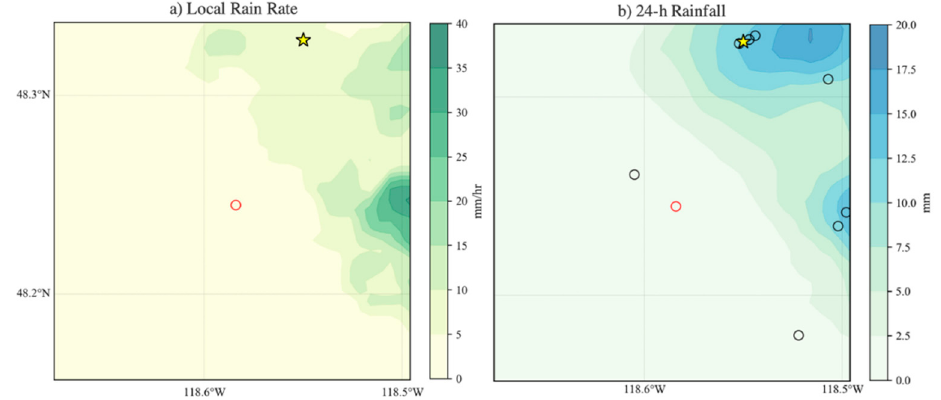
Figure 12. Plots of ( a ) rate rain (mm h − 1 ) at 2332 UTC 8 Aug 2017 and ( b ) 24-h rainfall (mm) from 1200 UTC 8 August 2017 to 1200 UTC 9 August 2017 over the 20 km by 20 km domain centered on the fire start location of the Bridge Creek Fire. The yellow star denotes the location of maximum stroke density, and black (red) circles represent the NFS flashes (FS flash).